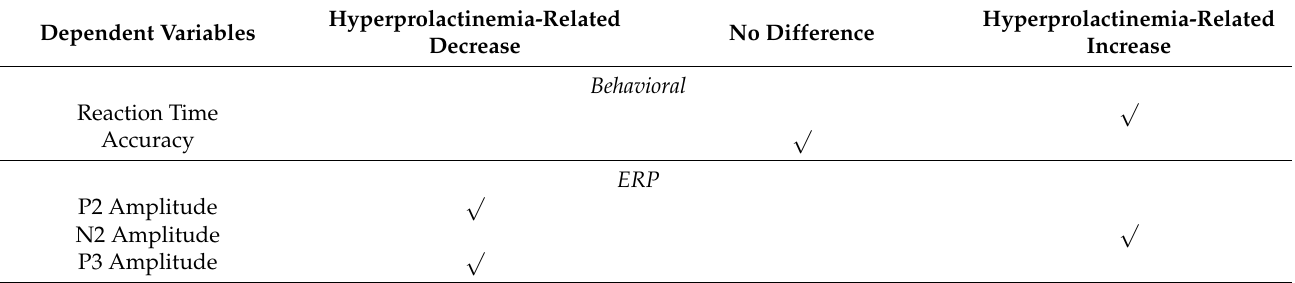
Table 2. Summary of differences in behavioral and ERP amplitudes between the two